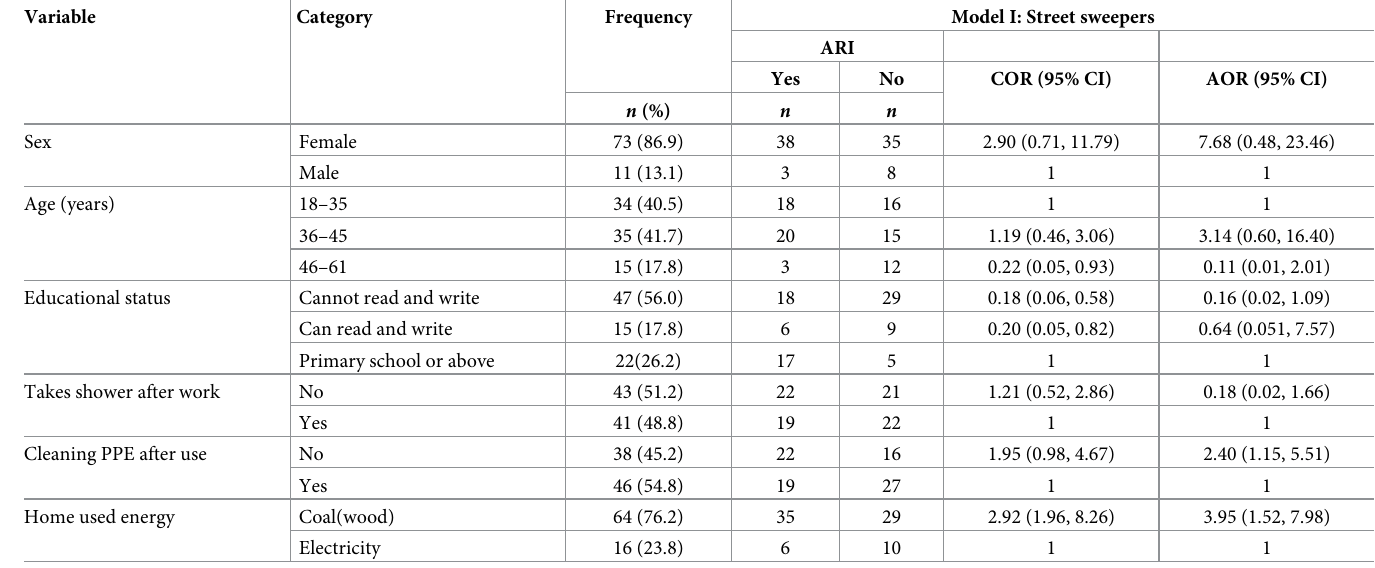
1, reference category.